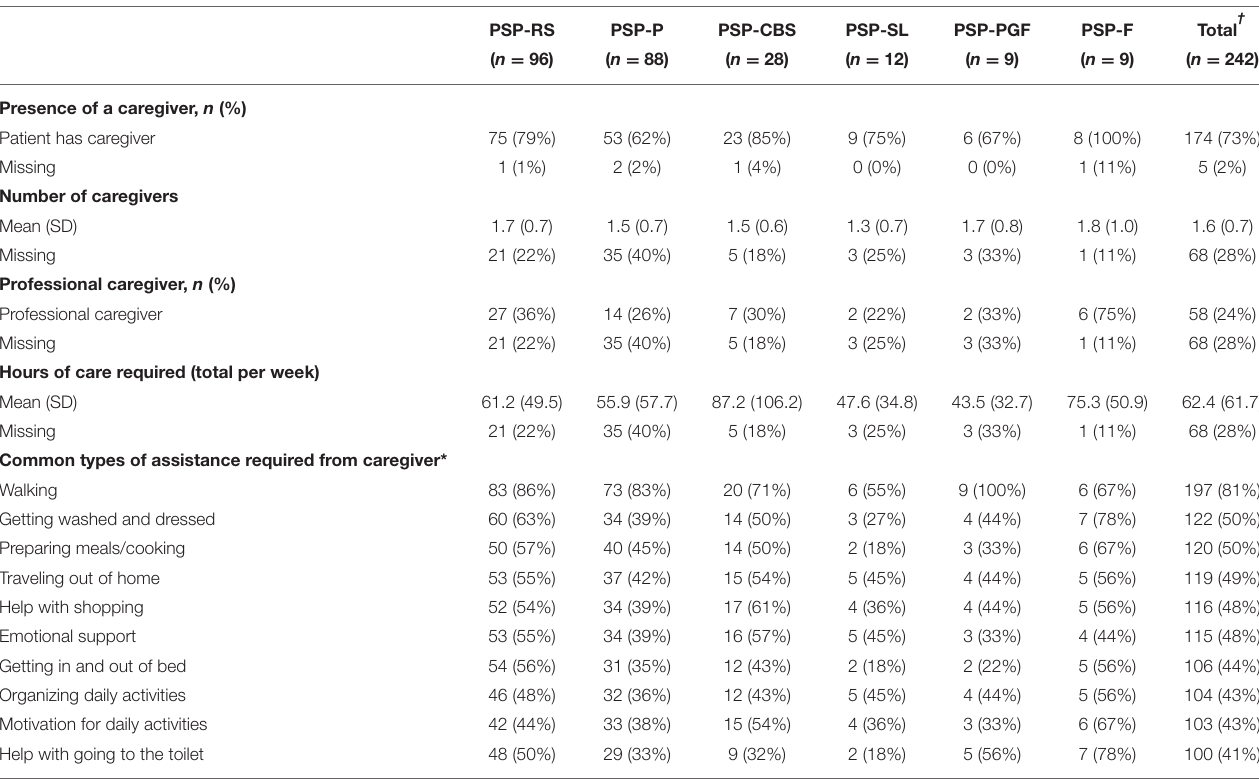
TABLE 3 | Caregiver burden, by PSP